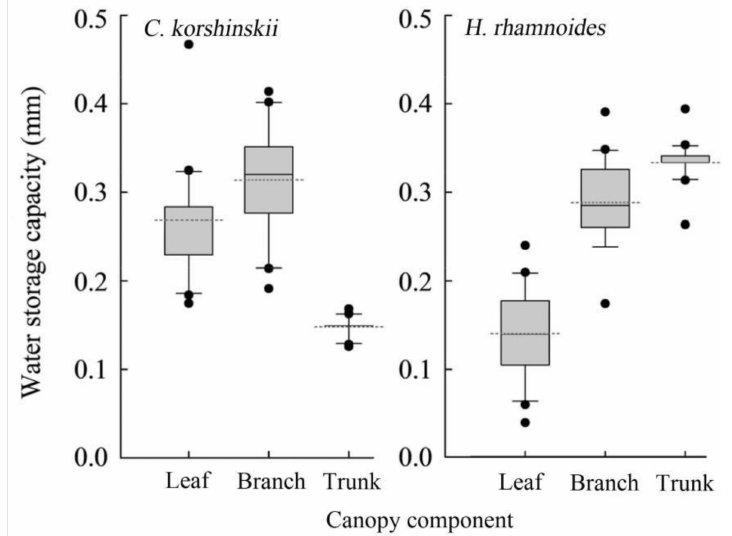
Figure 5. Box-and-whisker diagrams of the water storage capacity of leaf, branch, and trunk for C. korshinskii and H. rhamnoides , showing the mean value (the dotted line), standard deviation, and 25th, 50th, 75th, and abnormal percentile values.